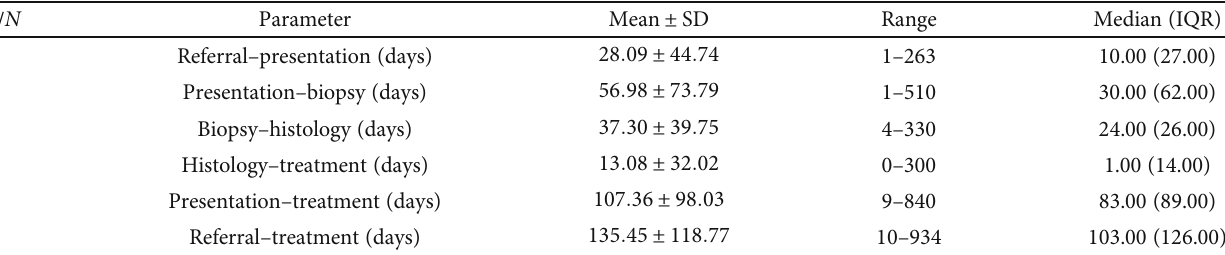
Table 1: Waiting times for all patients.